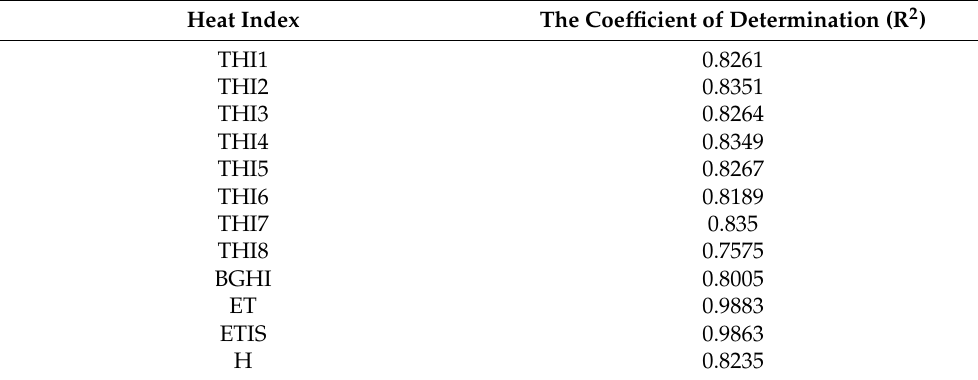
Table 3. The Coefficient of Determination (R 2 ) between the sow’s heat transfer and heat